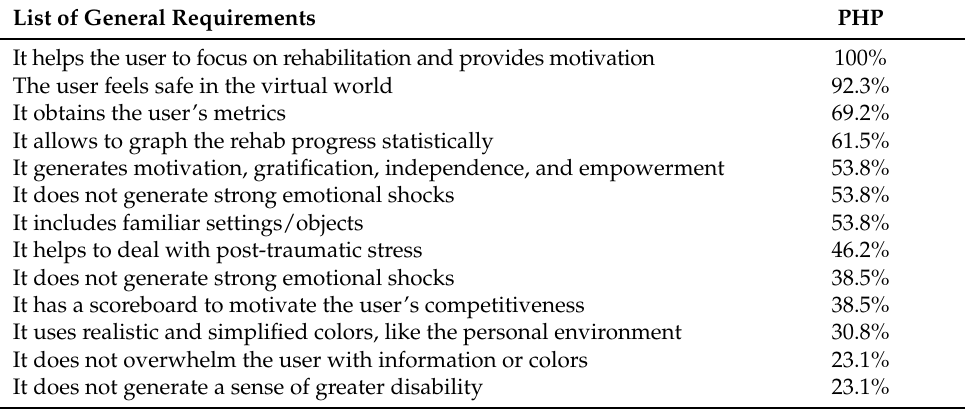
Table 6. List of requirements and perception of